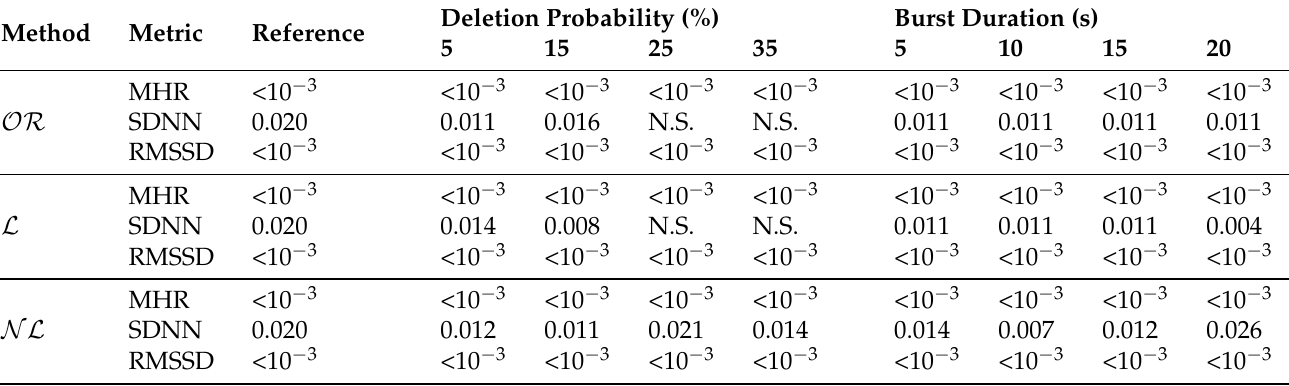
Table 2. p -values of ranked signed test for supine/tilt discrimination of time-domain metrics. N.S.: Not significant ( p >